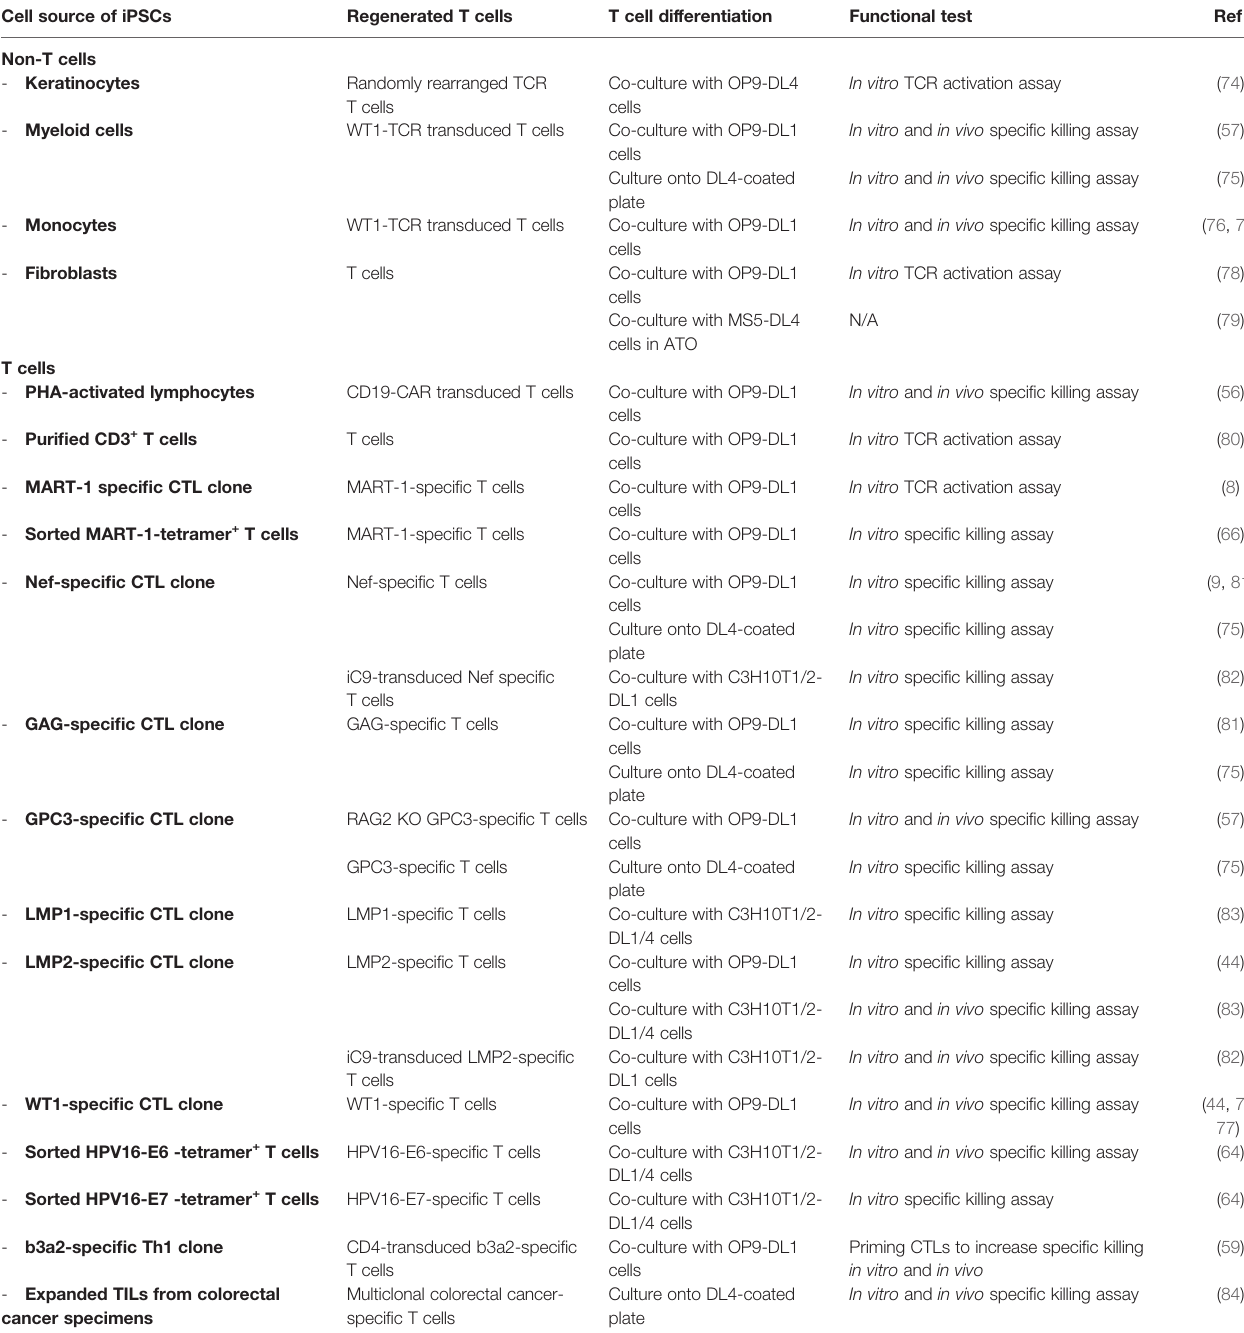
TABLE 1 | Generation of T cells from human